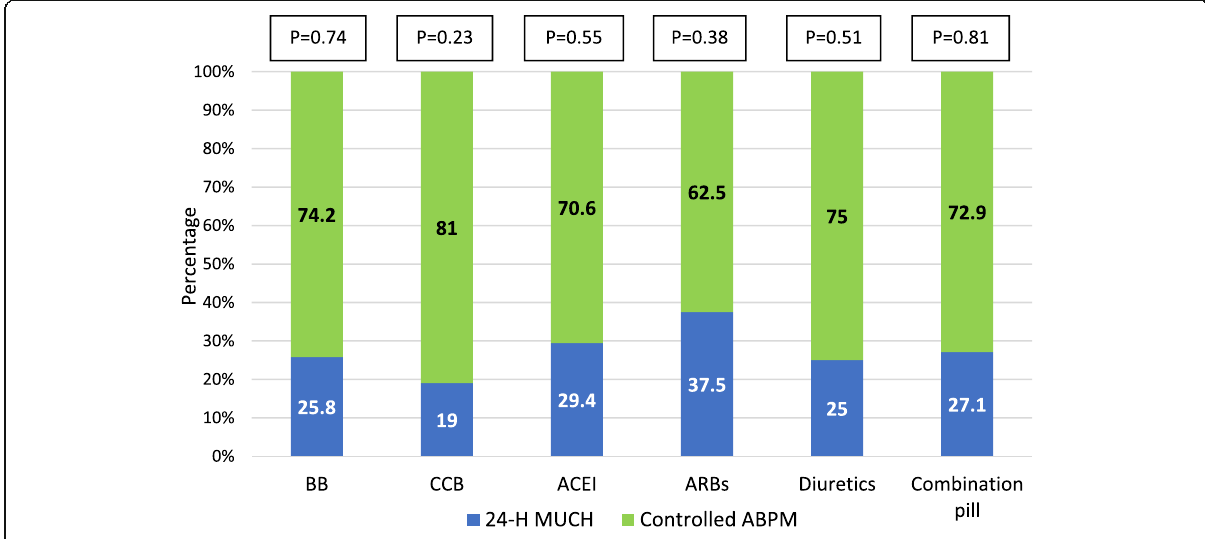
Fig. 2 Classes of antihypertensive drugs and prevalence of 24-h MUCH in group 1